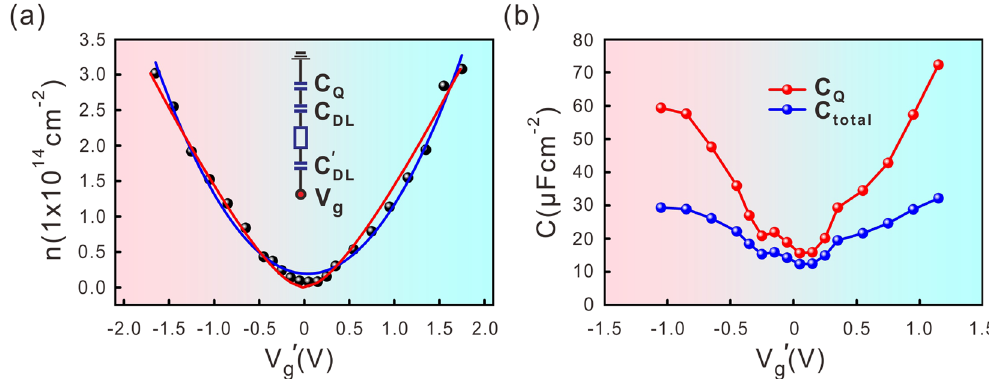
Figure 3. ( a ) The carrier density as a function of the modified gate voltage measured from the charge neutrality point. The blue line is the second order polynomial fitting curve assuming the quantum capacitance of graphene is much smaller than the double-layer capacitance. And the red line is the fitting curve taking the contribution of the electric double-layer capacitance into account. ( b ) The total capacitance and the quantum capacitance of the graphene sheet calculated using the fitted double-layer capacitance. Both curves show a typical